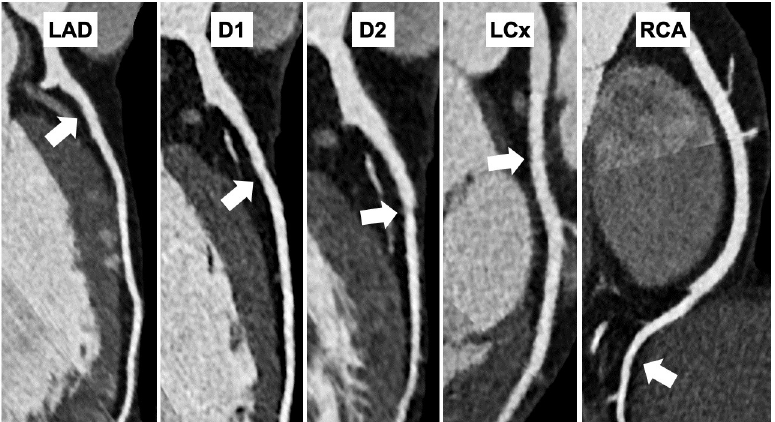
Fig 2. CCT of a male referee with non-significant coronary artery atherosclerosis. The CCT pictures of a 45-year- old asymptomatic male handball referee with no cardiovascular risk factors except for slightly elevated LDL cholesterol level. The examination was performed due to significant lateral ST-T changes recorded during exercise stress testing and revealed non-significant low-density non-calcified atherosclerotic plaques in all main coronary arteries (arrows). Statin therapy was initiated, and regular cardiology follow-up was indicated. Abbreviations: CCT, cardiac computer tomography; LAD, left anterior descending artery; D1, first diagonal artery; D2, second diagonal artery; LCx, left circumflex artery; RCA, right coronary artery.